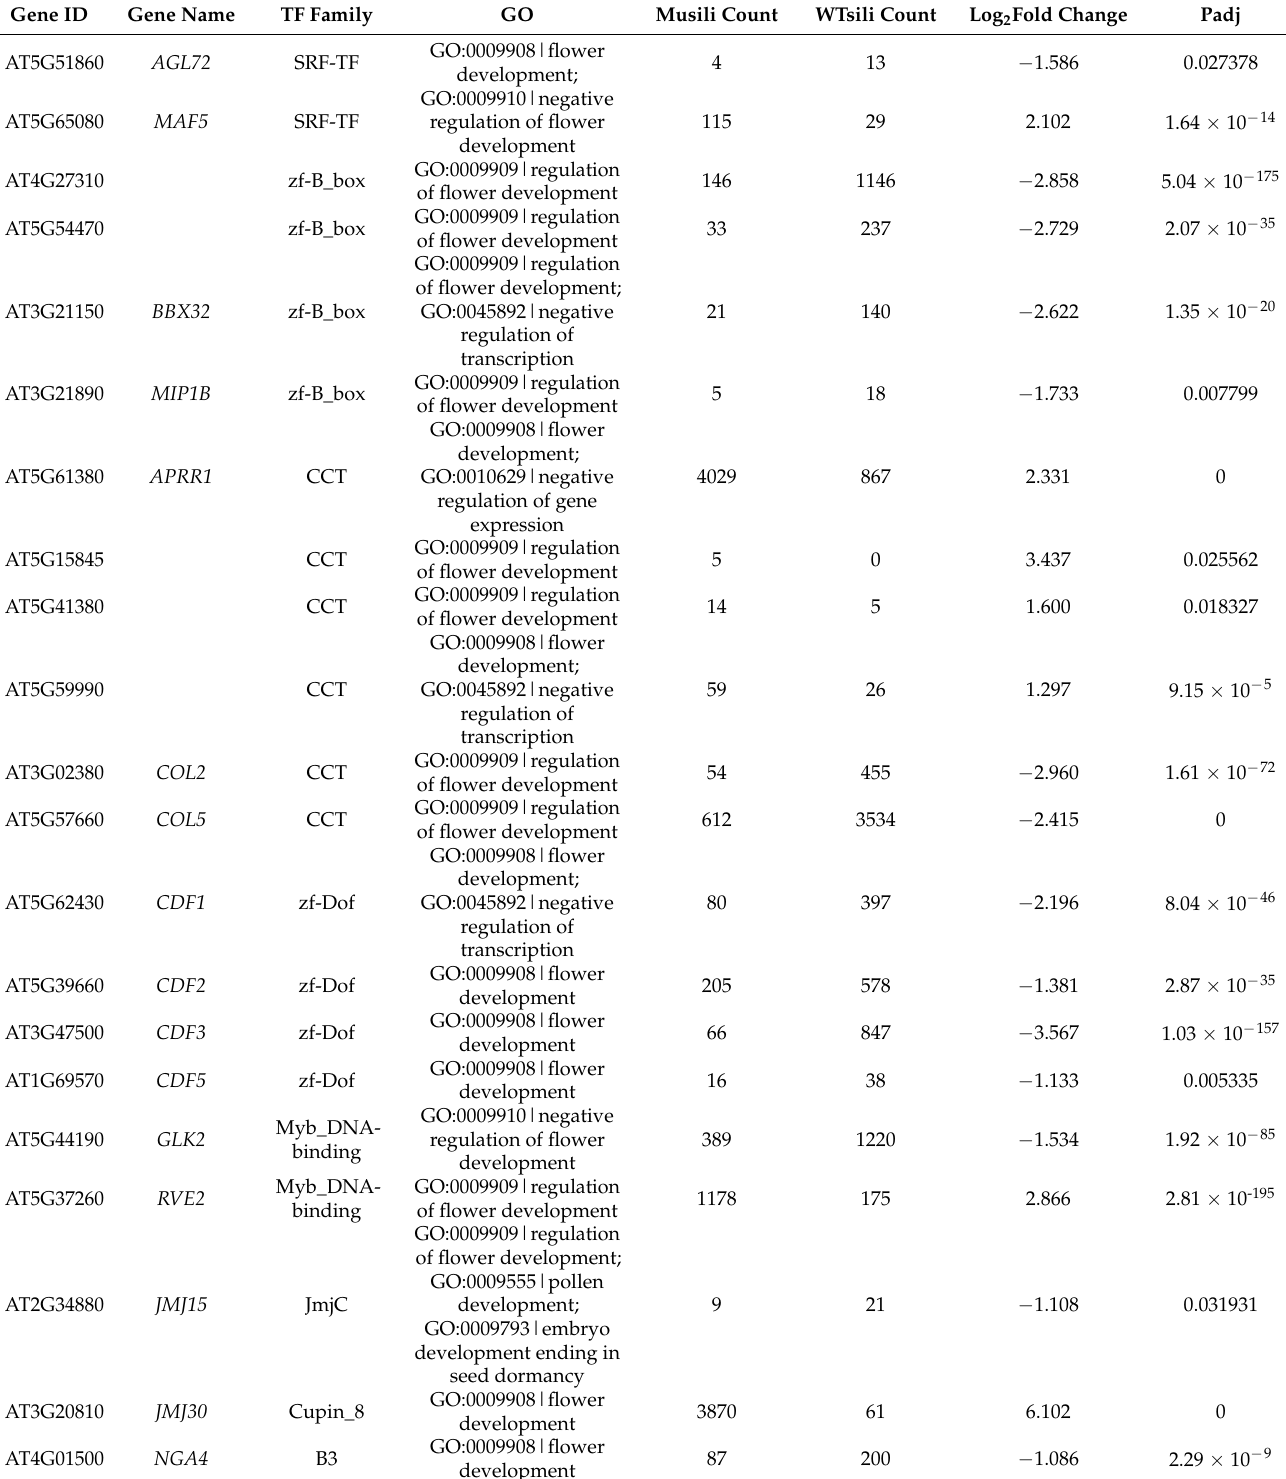
Table 4. Analysis of TFs related to flower and seed development in the pip1s − mutant and WT plants. Gene